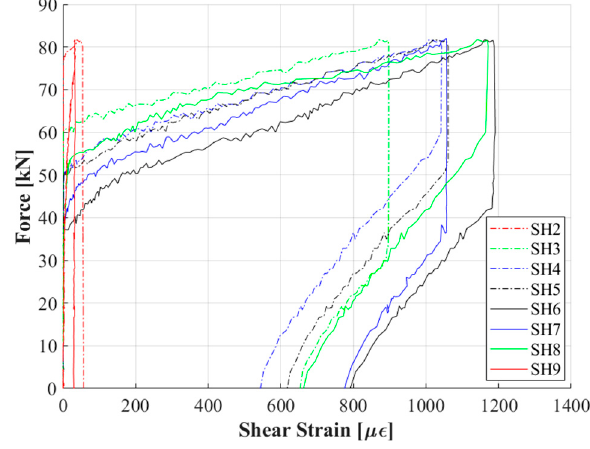
Figure 19. Tensile shear strain of the B8-P47/46 beam.